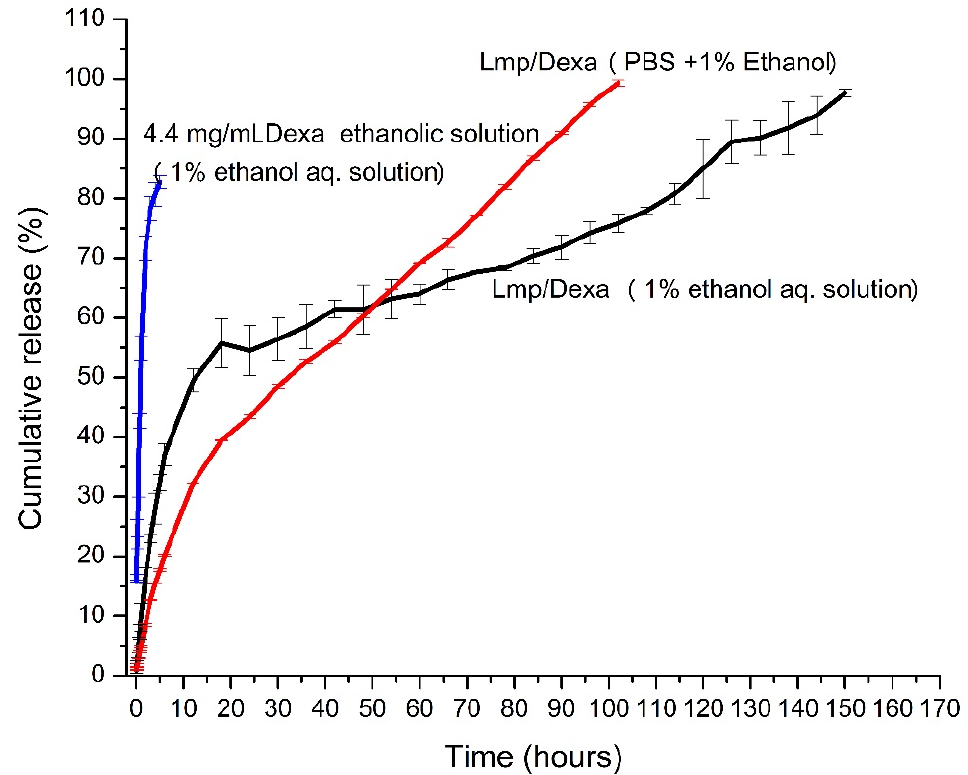
Figure 6. Cumulative release (%) versus time of Dexa released from Lmp/Dexa in 1% ethanol aqueous solution and in PBS containing 1% ethanol, and from Dexa ethanolic solution in 1% ethanol aqueous solution.